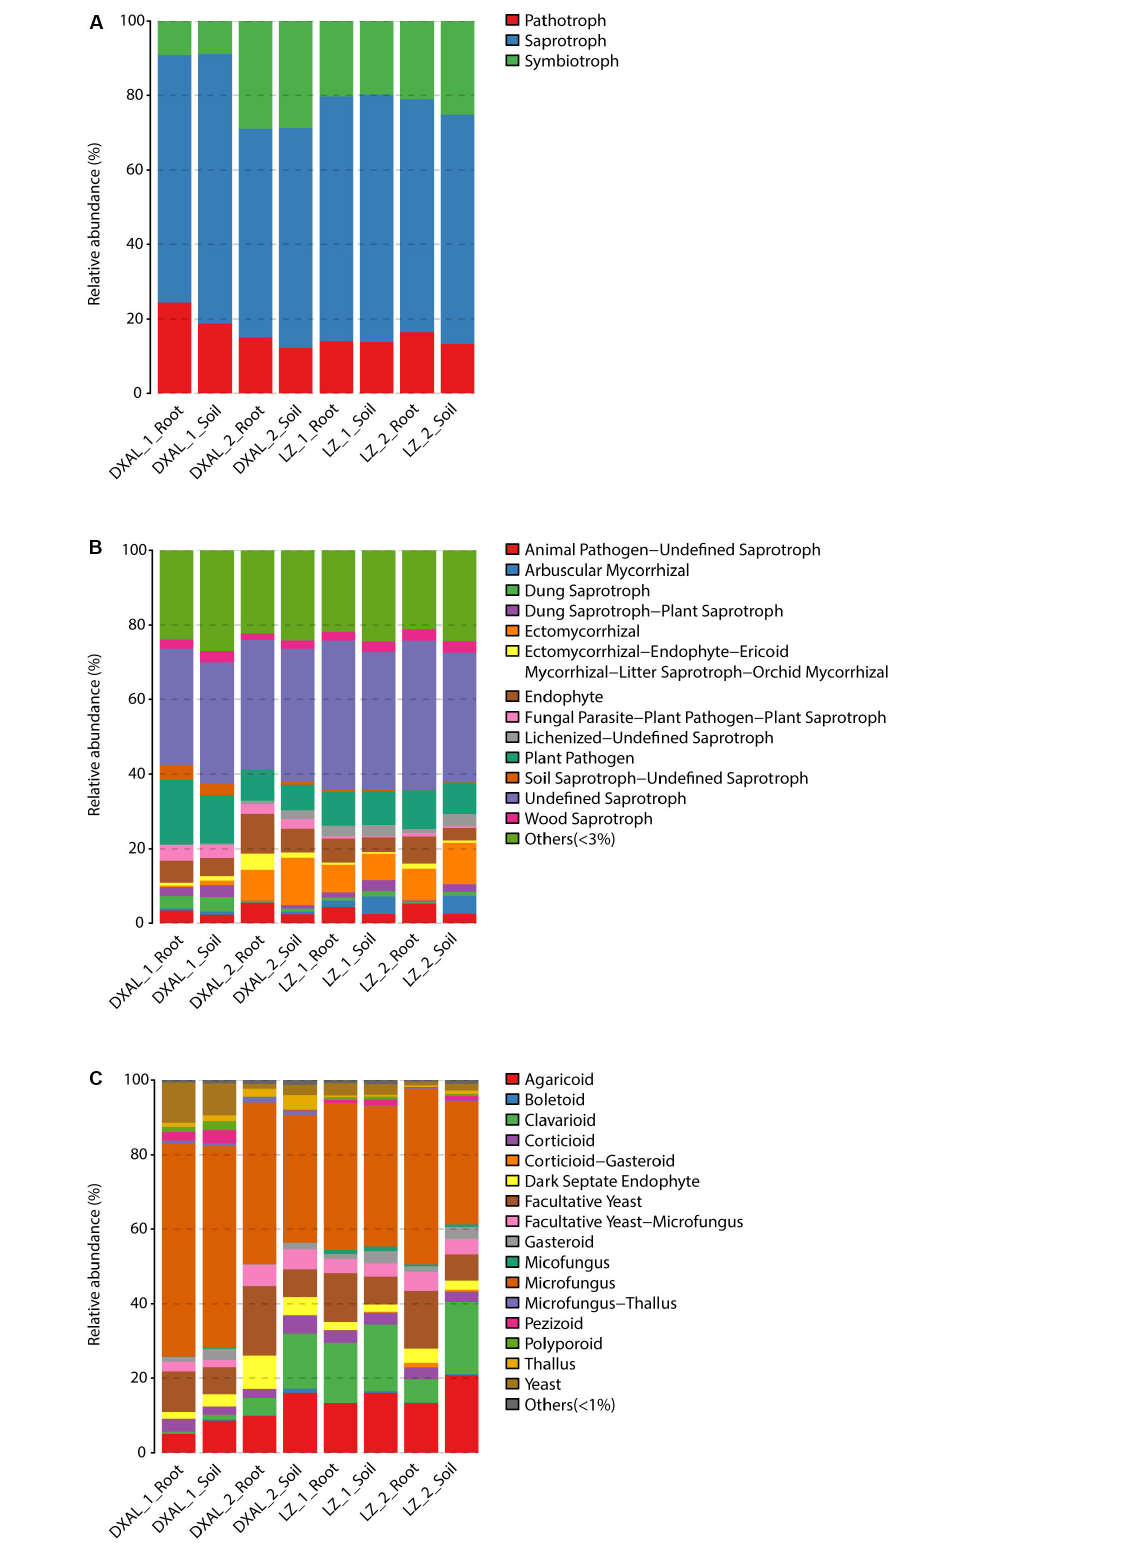
Frontiers in Microbiology |